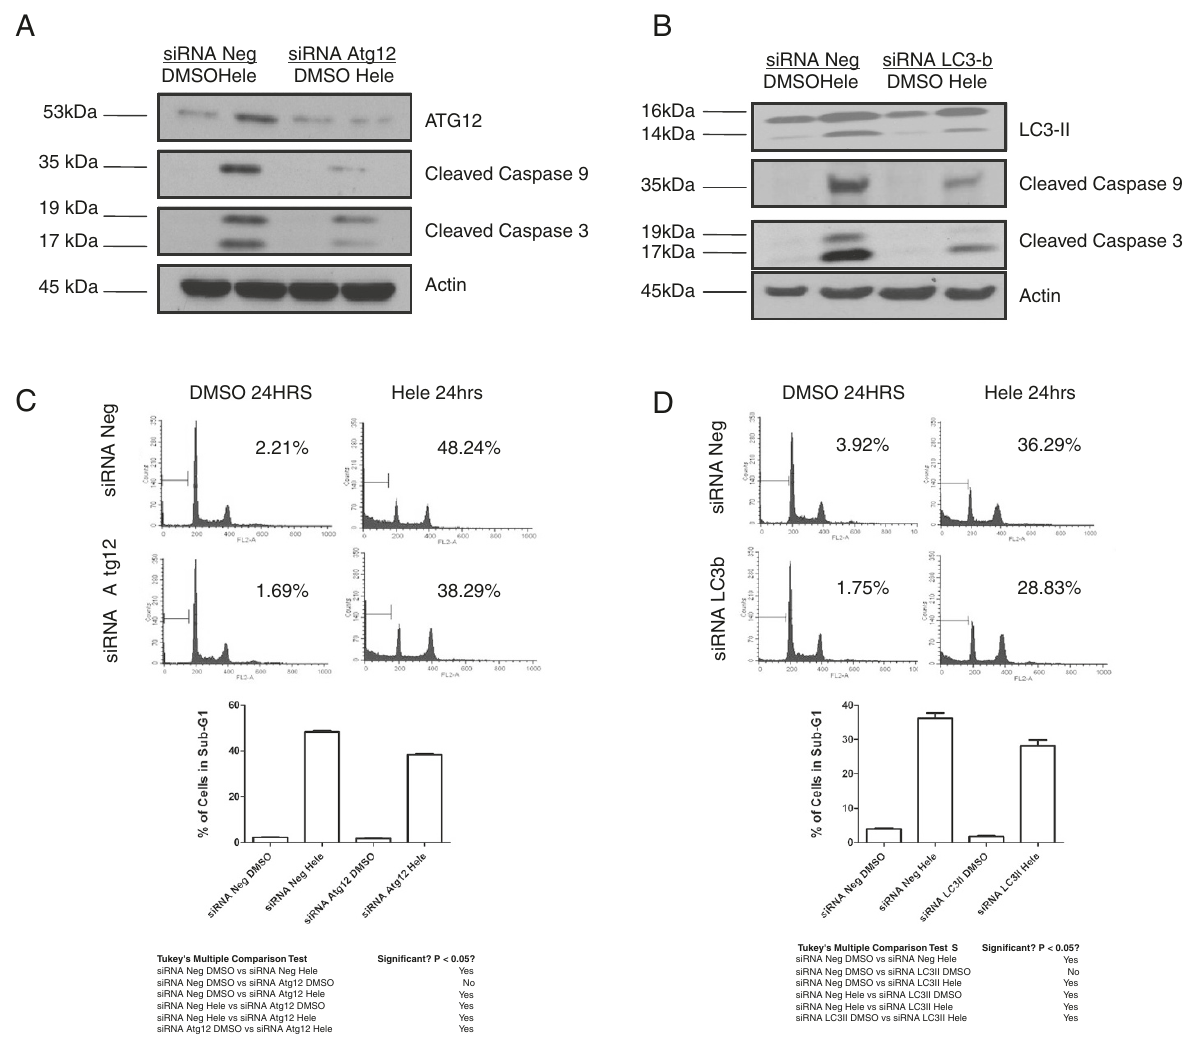
Figure 6 Helenalin induced caspase cleavage and autophagy is dependent on Atg12 and LC3-B. A2780 cells were transfected with either non-targeting siRNA (siRNA Neg) or Atg12 or LC3-B-specific siRNA for 24 h and then treated with either DMSO or helenalin for 24 h. Cells were harvested and ( A and B ) cell lysates were subjected to immunoblot analysis for Atg12, LC3-B, cleaved PARP, caspase 3 or 9 or ( C and D ) analyzed for cell cycle phase distribution by FACS. All experiments were performed in biological triplicates. Actin was used as the loading control. One way ANOVA was performed between control and treatment groups, and significant differences were observed between the groups as indicated in Figure 6C and D. Categories significant after multiple comparison are marked as “ Yes ” .(p-value < 0.05; Tukey ’ s multiple comparison